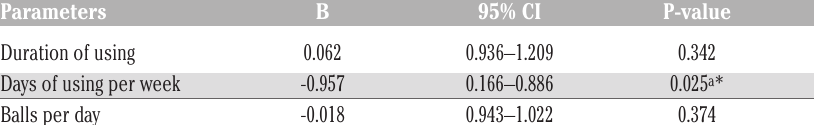
Table 4. Multivariate logistic regression between the MRI appearance of spinal cord lesions and historical features of N 2 O abuse.